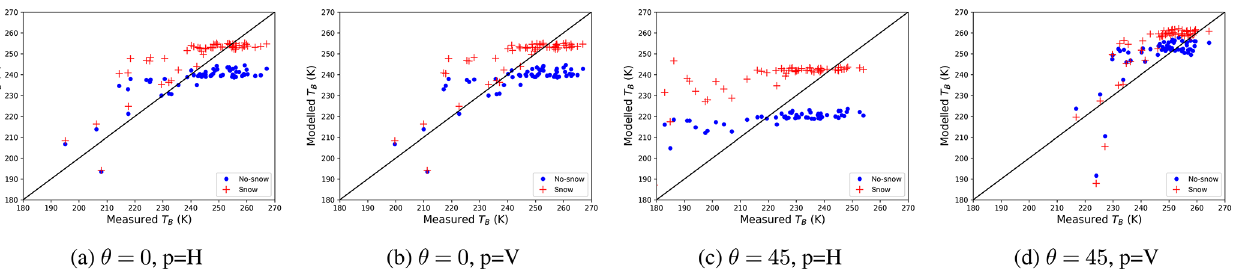
Figure 10. Scatter plots illustrating the comparisons between the EMIRAD-2 data and the T B simulated with GO roughness included . Results corresponding to the setup with snow are marked in green, and without snow is in